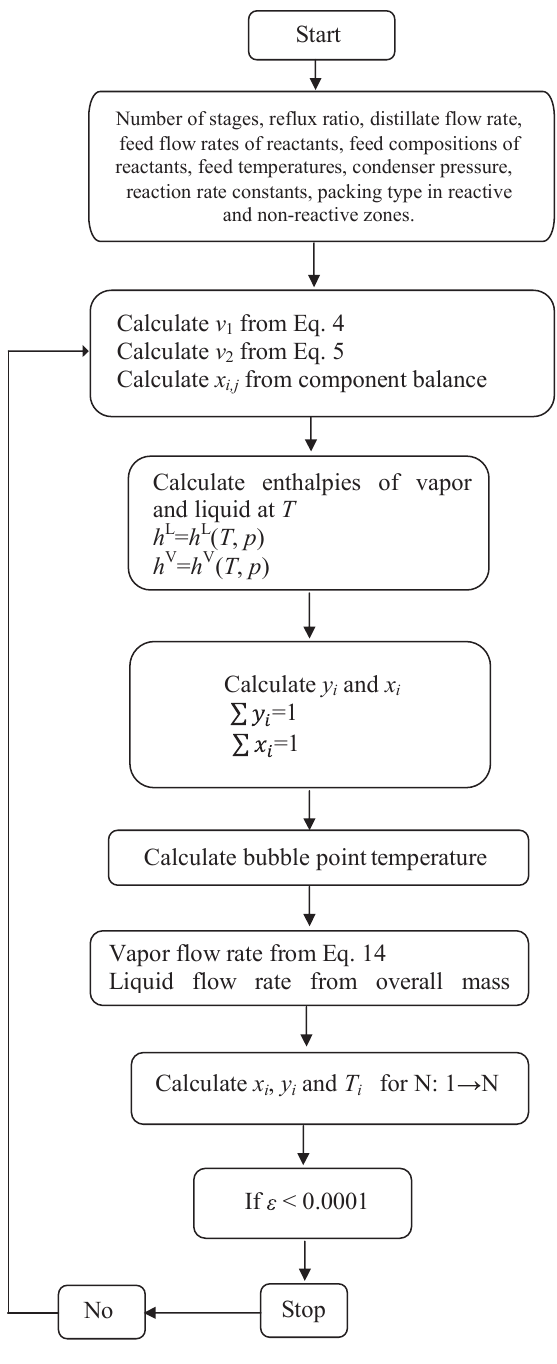
Fig. 4 – Flow chart for the algorithm of the equilibrium stage